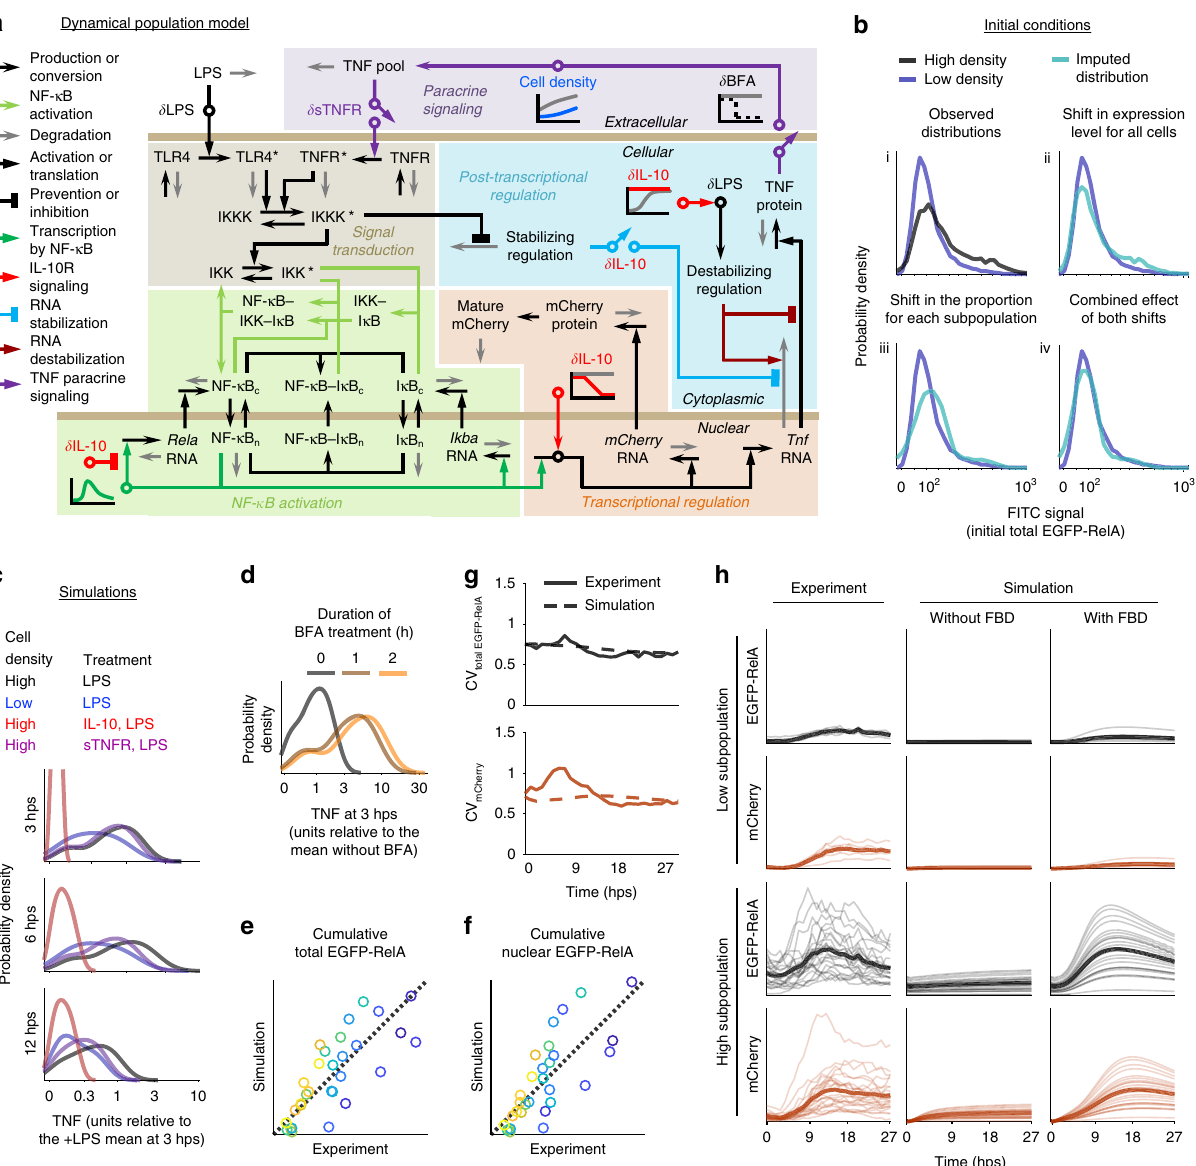
Fig. 3 A dynamical population model explains intracellular and extracellular signaling and regulation. a The diagram summarizes variables, reactions, and mechanisms in the model of macrophage activation. Symbols: bold non-italicized text for variables; horizontal bars for compartment boundaries; n for nuclear and c for cytoplasmic; asterisks for activated receptors or kinases; delta symbol and circles for perturbation-speci fi c effects; diagonal arrows for a perturbation ’ s effect; and graphs for time-dependent processes. b Generation of comparable distributions of initial values (data from Supplementary Fig. 2r). The observed distributions in ( i ) are in non-comparable units. To initiate simulations with NF- κ B distributions that vary between high and low cell density and that match experimental observations for EGFP-RelA, we impute from an observed high density distribution (black) a low density distribution (teal) that matches the observed low density distribution (blue). The transform shifts the distribution ( ii ) and adjusts the proportion of cells in high vs. low states using a Gaussian mixture model of two populations fi t to the high density distribution ( iii ), such that the combined transform ( iv ) generates an imputed distribution matching the observed low-density distribution (blue) with units relatable to high density (black). c – d Simulated TNF distributions from the calibrated model match experimental trends for cell density and ligand conditions in Fig. 1d, e and BFA conditions in Fig. 1c. All cells have the topology in a and are heterogeneous in initial value and transcription of Rela RNA and initial value of cytoplasmic NF- κ B – I κ B, derived from b . e – h Comparison of simulated and experimental outcomes for n = 30 cells at high density with sTNFR and LPS treatment. e – f Cumulative total EGFP-RelA (R 2 = 0.61, one-tailed permutation test p = 3 × 10 − 7 ) and cumulative nuclear EGFP-RelA (R 2 = 0.60, one-tailed permutation test p = 4 × 10 − 7 ), calculated using time-integrated values. The dotted diagonal is the identity line, and axes are linearly scaled. Color-coding is the same as in Fig. 2c – e. g Coef fi cient of variation (CV) in mCherry and total EGFP-RelA expression over time. h Trajectories were grouped post hoc by high or low activation. Mean values are in bold. Simulations are shown with and without